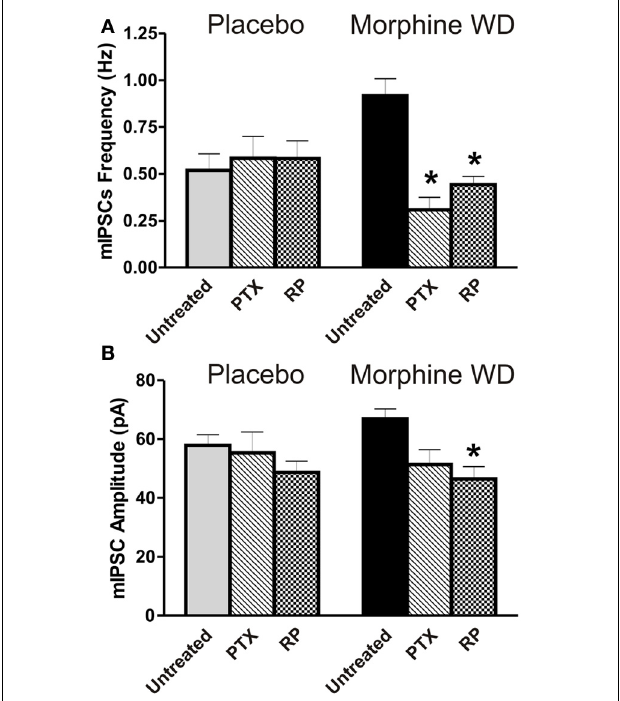
FIGURE 3 | Effects of Gi/o and cAMP inhibitors on CeA basal GABAergic transmission. (A) The Gi/o inhibitor PTX (250ng/ml) and cAMP inhibitor RP (500nM) prevented an increase in mIPSC frequencies in CeA neurons (PTX: n = 6 and RP: n = 13) from morphine WD rats. In contrast, these agents had no effects on mIPSC frequencies in neurons (PTX: n = 9 and RP: n = 16) from placebo rats. The values presented as untreated CeA neurons correspond to those neurons shown in Figure 1A . (B) By comparison to the untreated CeA neurons (the same data presented in Figure 1B ), RP significantly reduced mean basal mIPSC amplitudes only in neurons from morphine WD rats. In the presence of PTX, basal mIPSC amplitudes were not significantly different between placebo and morphine WD rats. Statistical significance: ∗ p < 0 . 05, was calculated by One-Way